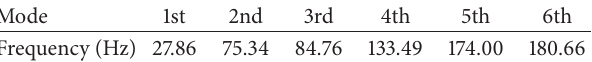
Table 8: First six natural frequencies of undamaged